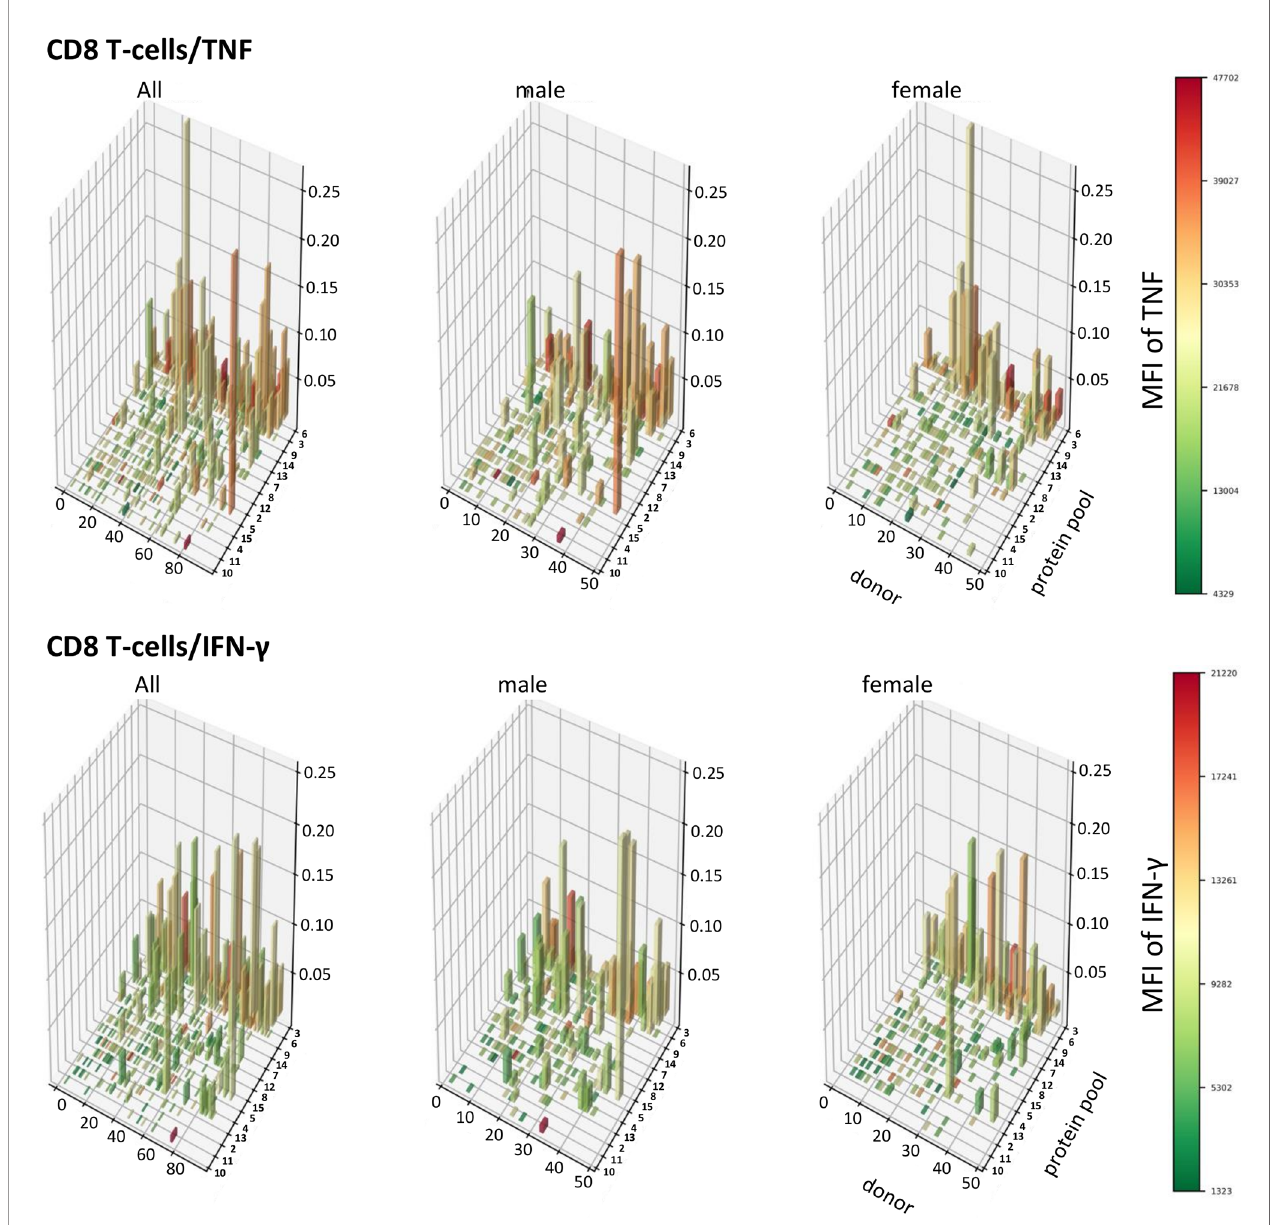
FIGURE 9 | Patterns of TNF and IFN- g producing CD8 T-cells appear similar in terms of size and distribution among men and women. 3D bar charts show all individual CD8 T-cell responses to each CMV peptide pool in the entire population (left), men alone (middle) and women alone (right). Participants are ordered by increasing median T-cell response size from left to right with respect to the entire population. Peptide pools are ordered by increasing median response size induced from front to back, also with respect to the entire population. Bar height corresponds to the percentage of cytokine producing CD8 T-cells, i.e., response size. Bar color corresponds to the MFI of the measured cytokine according to the displayed